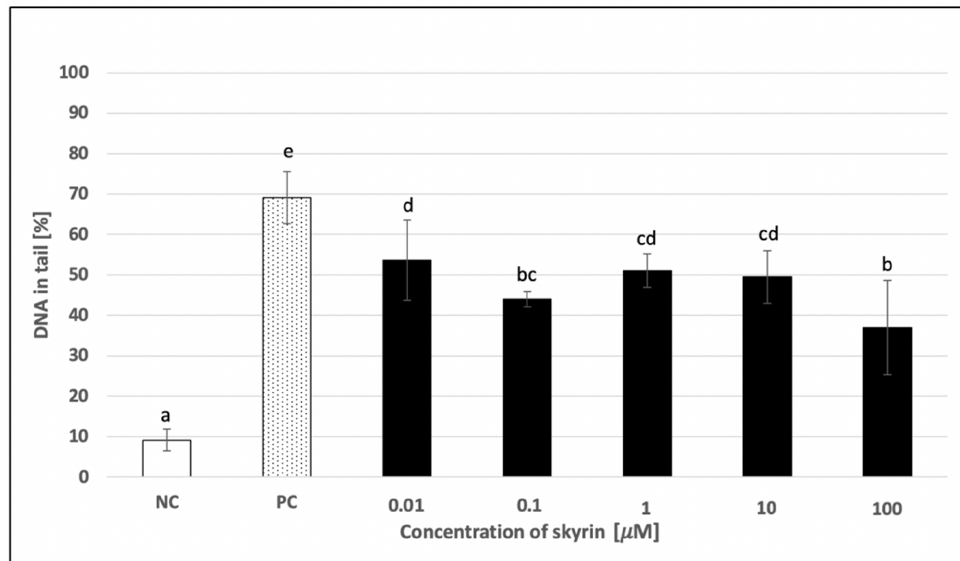
Figure 10. Evaluation of the potential DNA-protective effects of skyrin (SK) on human lymphocytes (1 h treatment) at different concentrations, using the comet assay. Negative control (NC)—untreated cells; positive control for comet assay (PC)—cells treated with 440 µ M hydrogen peroxide. Tested samples were treated with a different concentration of skyrin (1 h treatment), and hydrogen peroxide (440 µ M) was subsequently added (5 min treatment). Results were analyzed by ANOVA single-step multiple comparisons of means using LSD tests, and comparisons between the mean values were considered significant at p < 0.05. Similar letters represent samples with no statistically significant differences between them. All experimental data in this work are from at least three independent experiments.